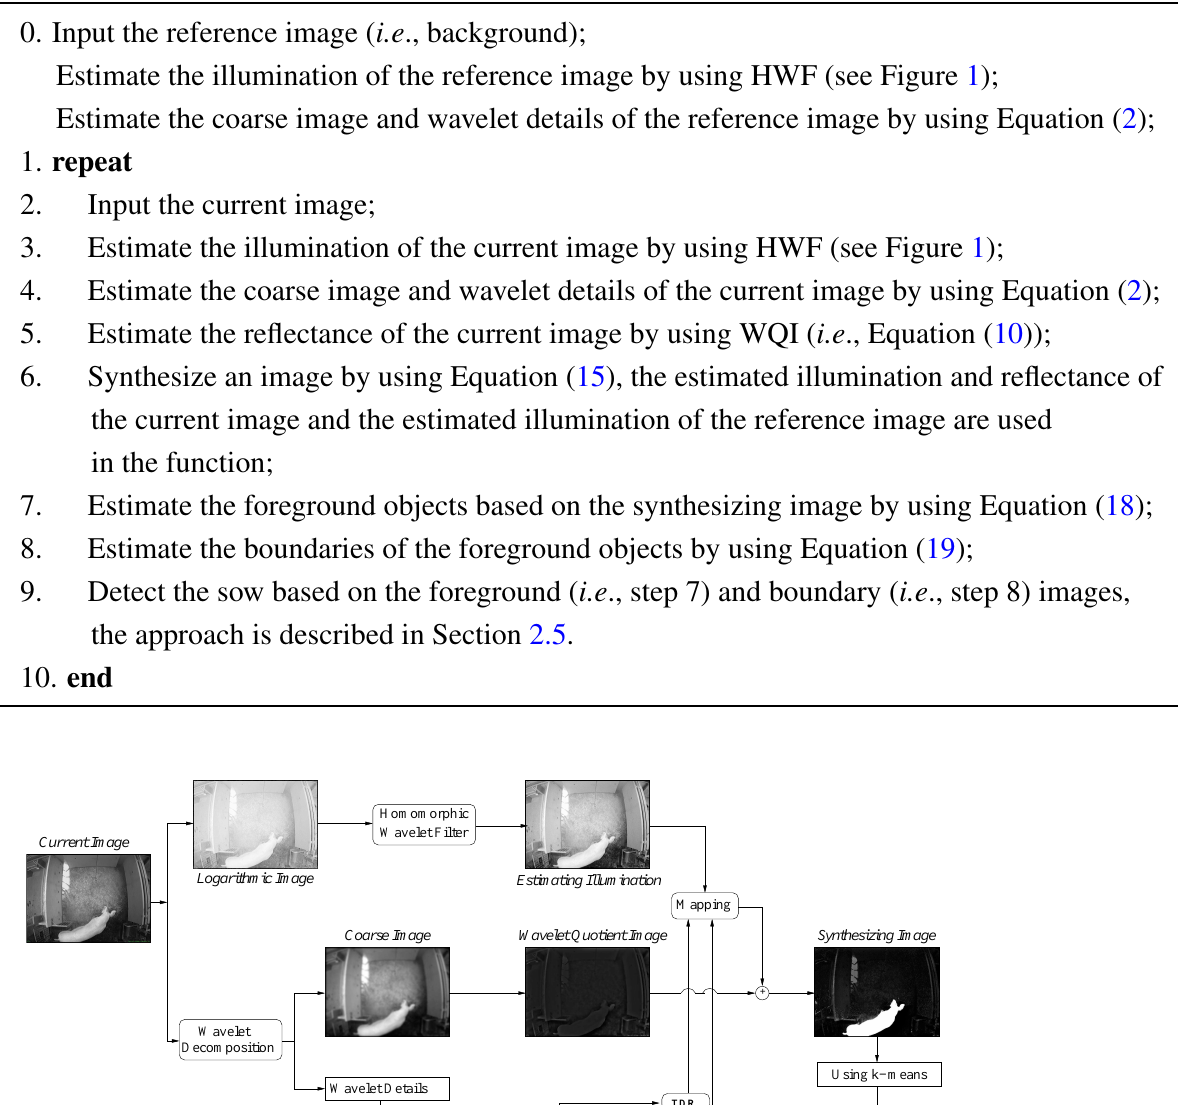
Table 1. The pseudocode of our algorithm.